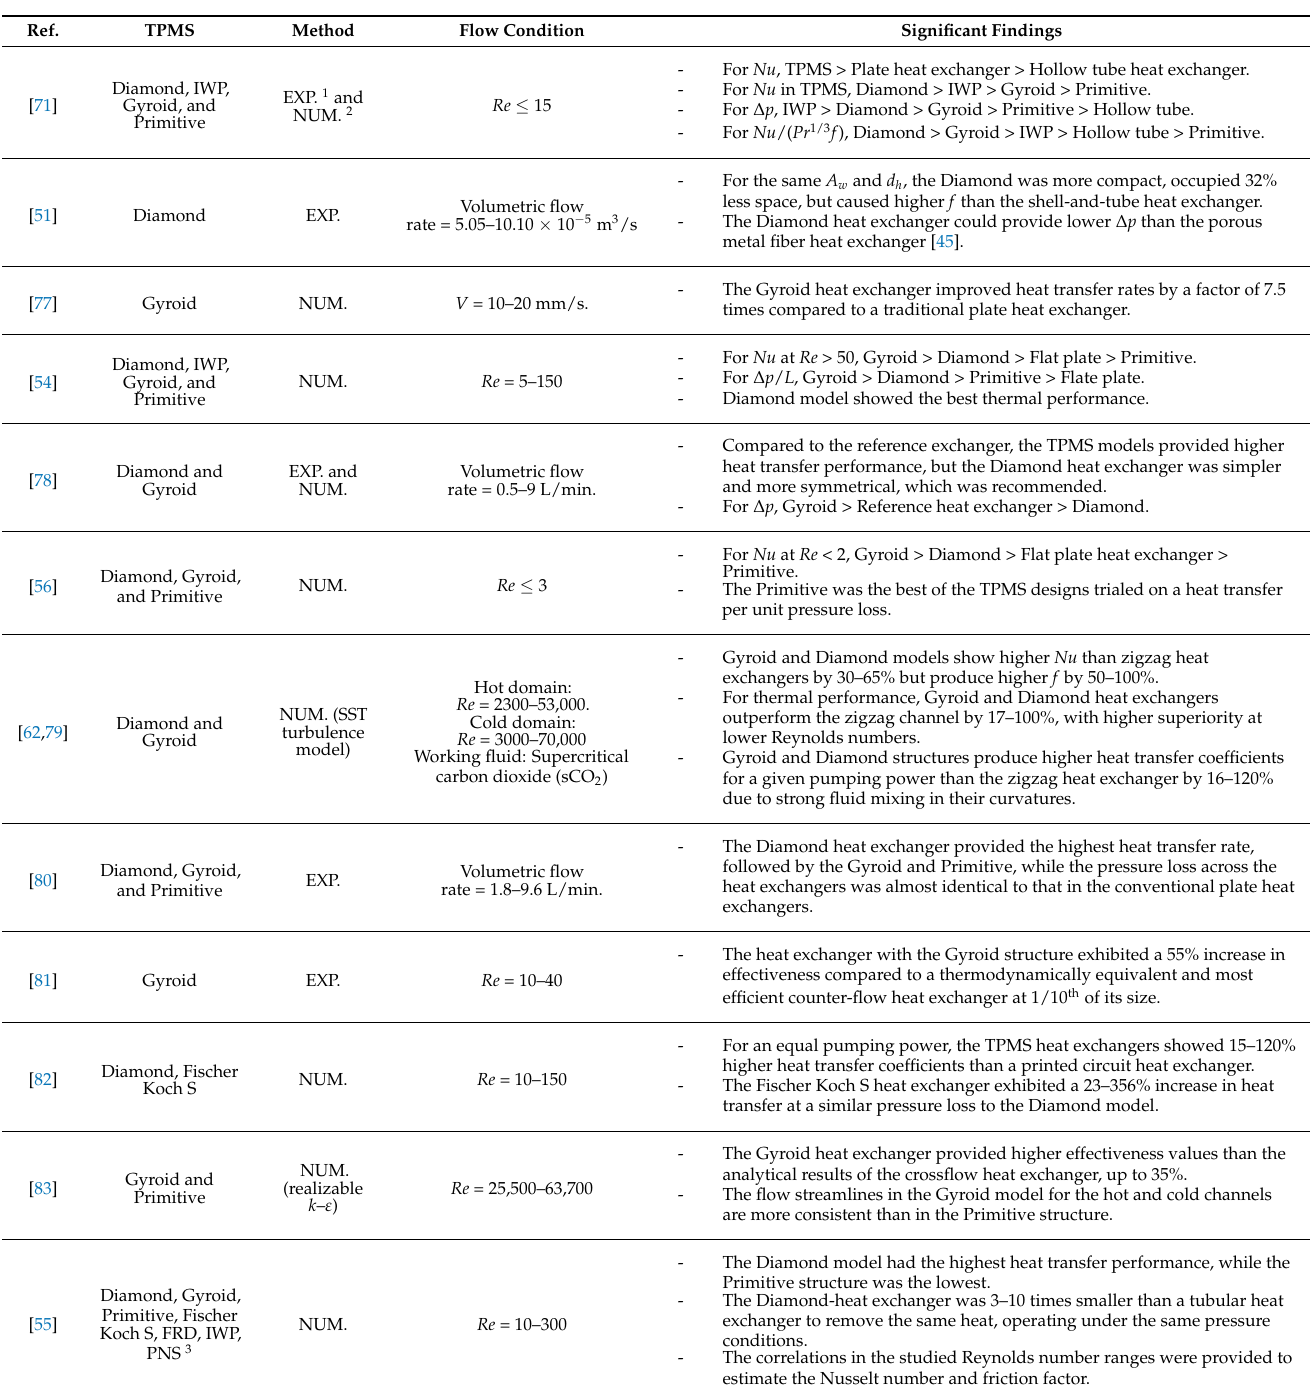
Table 1. Reviews of the investigation of the TPMS structures for two fluid heat exchangers.